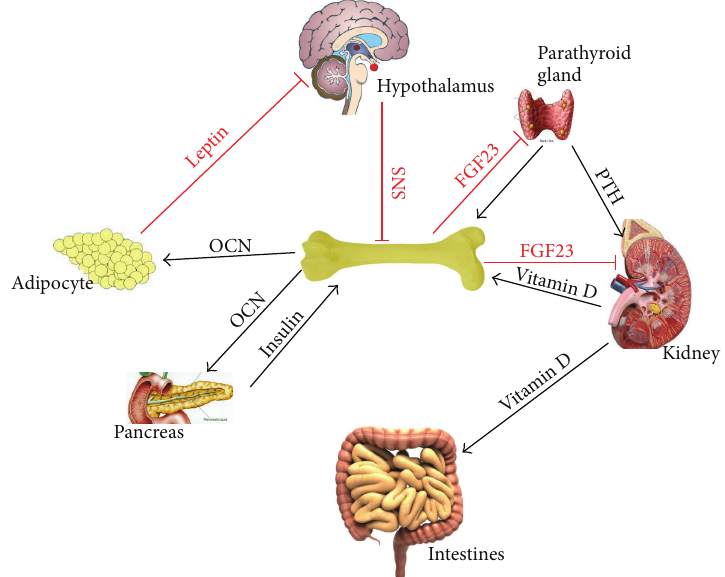
Figure 1: Skeleton regulates mineral and energy homeostasis. In mineral homeostasis, low level of circulating calcium stimulates the parathyroid gland to release PTH, which later upregulates blood calcium levels by stimulating osteoclastic bone resorption, renal calcium reabsorption, and renal production of Vitamin D to increase intestinal calcium absorption. Increased serum phosphate and Vitamin D stimulate FGF23 synthesis and releasing in bone, which subsequently inhibits PTH production from the parathyroid gland, inhibits Vitamin D production in the kidney, and promotes renal phosphate excretion. Leptin inhibits bone formation and the homeostatic function of the skeleton indirectly through SNS. However, SNS signalling also increases the production of OCN from bone, which feeds into the positive loop. OCN affects pancreatic 𝛽 cells and increases insulin level, which has feedback effect on bone, driving further production of OCN. OCN also acts on fat to increase the production of adiponectin and upregulates insulin sensitivity. FGF23, fibroblast growth factor 23; PTH, parathyroid hormone; SNS, sympathetic nervous